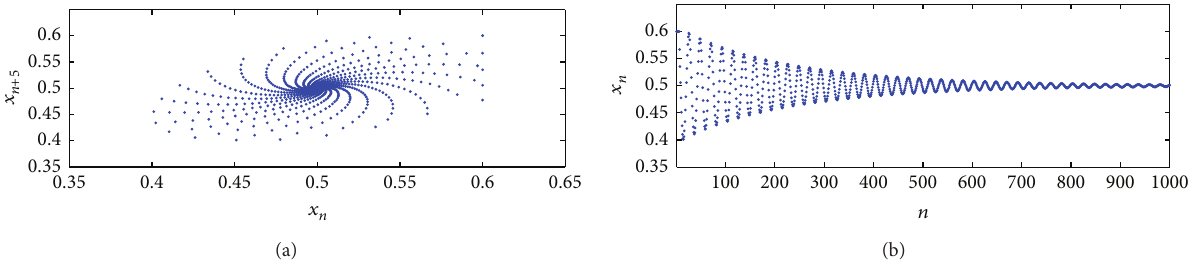
Figure 3: The positive equilibrium is asymptotically stable, where 𝑎 1 = 1.6 , 𝑎 2 = 0.8 , 𝑚 = 5 , and 𝑟 = 0.23 < 𝑟 1 = 0.2372 .